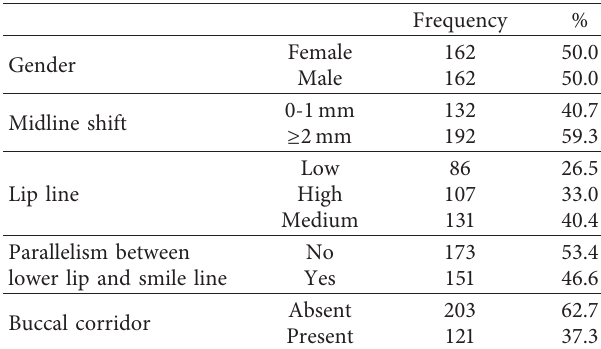
Table 1: Frequency distribution table of different smile parameters.